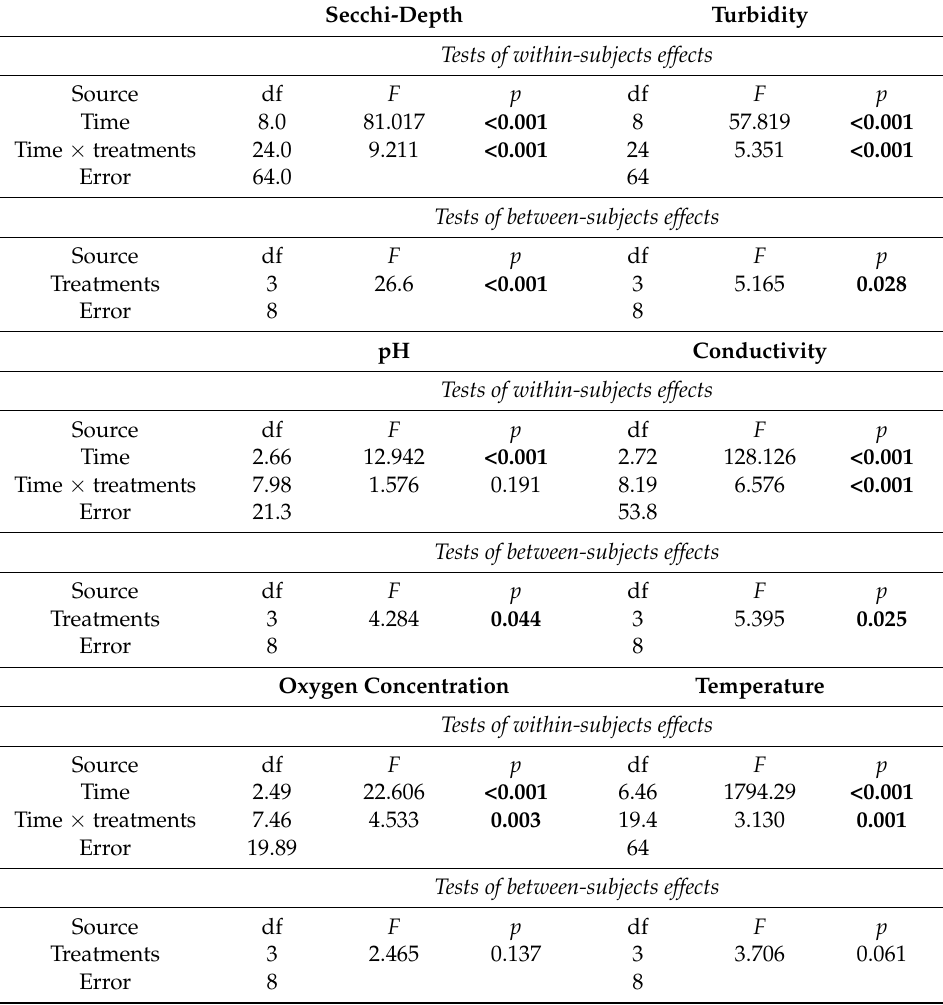
Table 1. Summary of repeated measures ANOVAs for water quality variables Secchi depth, turbidity (NTU), pH, Electrical Conductivity (EC, µ S cm − 1 ), oxygen concentration (mg L − 1 ), and temperature ( ◦ C), with treatments (dredging, LMB addition, and their combination) as the fixed factor. All data, except pH, were log-transformed prior to analysis to fulfill the variance homogeneity requirements 1 . Significant differences ( p < 0.05) are indicated in